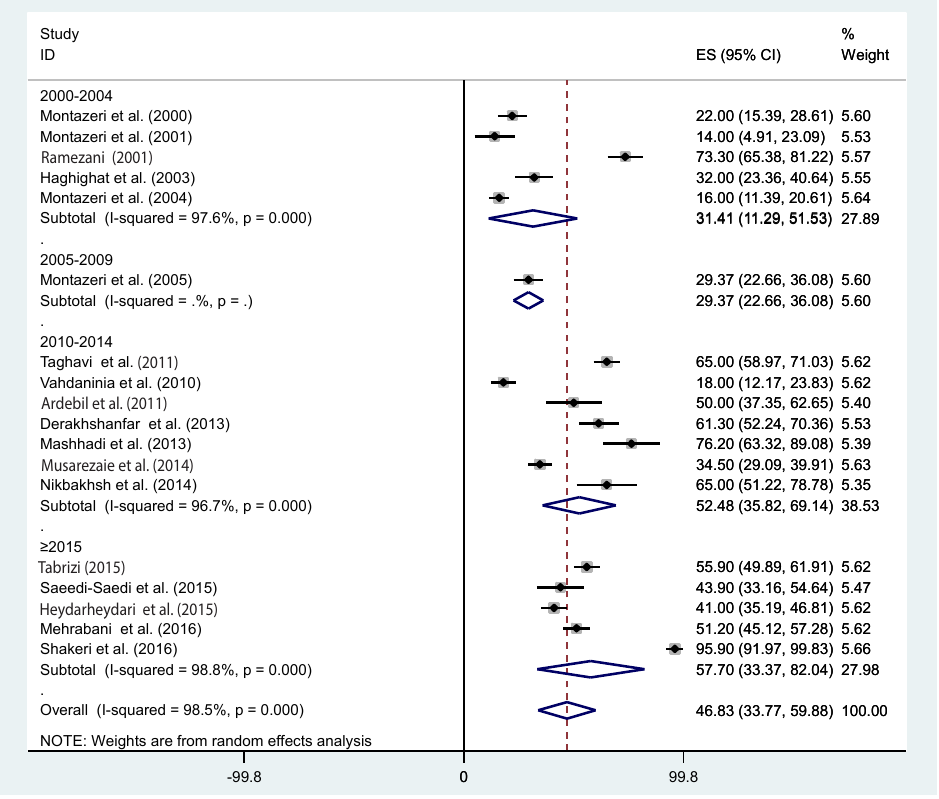
Figure 4. Prevalence of depression among Iranian breast cancer patients based on the year of publication. ES, effect size (prevalence); CI, Confidence interval.